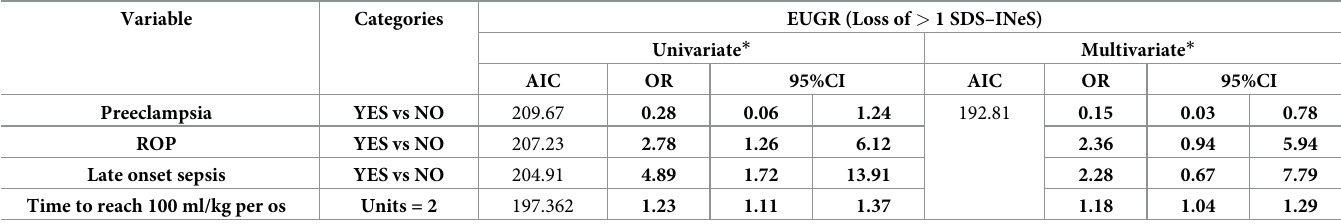
Table 3. Odds Ratio (OR) and relative 95% Confidence interval (95%CI) of univariate and multivariate logistic regression.